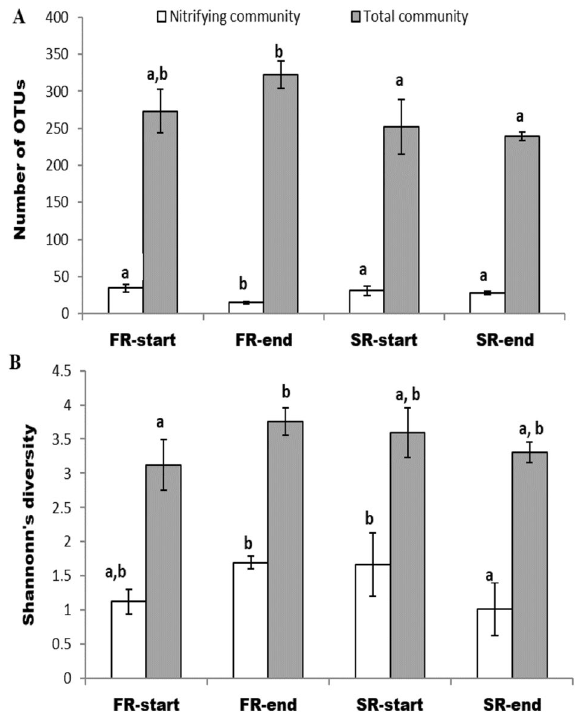
Figure 5. Diversity indices based on the pyrosequencing data of the total and the nitrifying communities. ( A ) Richness (observed OTUs). ( B ) Shannon’s diversity index. For freshwater reactor (FR): F3–F6 (FR start ) and F9–F14 (FR end ). For seawater reactor (SR): S3–S6 (SR start ), and S10–S13 (SR end ). Equal letters (a, b) above bars indicate no significant difference ( p > 0.05) and different letters (a, b) indicate significant statistical differences ( p < 0.05) by ANOVA and Tukey’s multiple comparisons. Error bars show standard error of the mean.